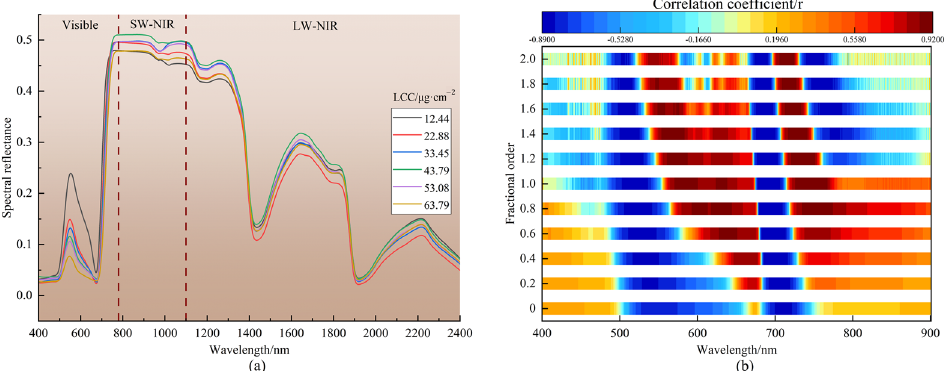
Figure 1. Leaf spectral curves of litchi with different LCCs ( a ); correlation coefficients between LCC and hyperspectral reflectance between 400 and 900 nm (0–2 order, 0.2 per step) ( b ). 0 order refers to the original reflectance, the dash line refers to the cutting line of the different spectral regions.